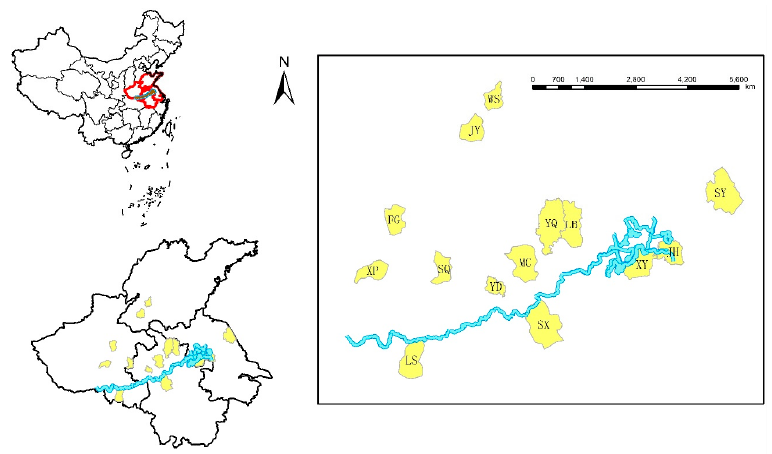
Figure 1. Map of the 14 counties in the